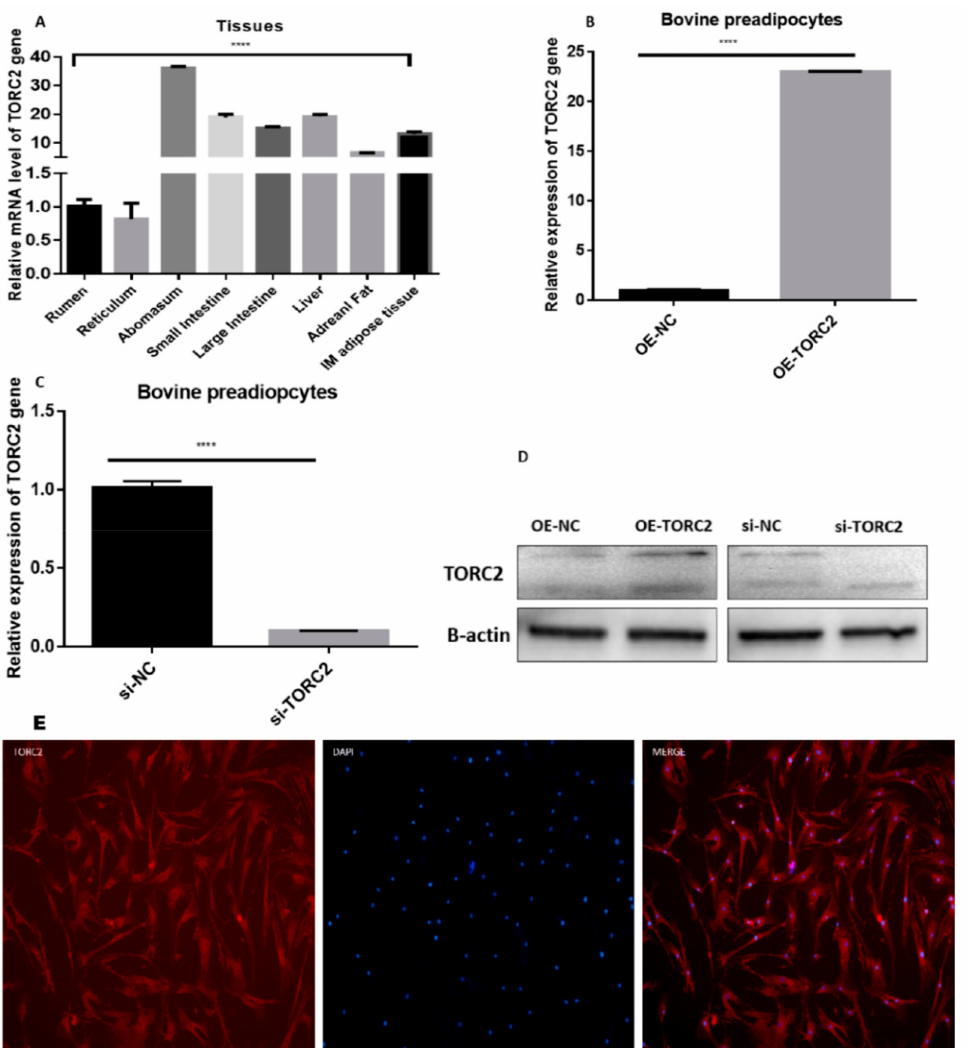
Figure 1. Transfection e ffi ciency, tissue and cellular expression and sub cellular localization of the transducer of regulated cAMP response element-binding protein (CREB) 2 ( TORC2 ) gene. ( A ) The mRNA expression level of the TORC2 gene in di ff erent tissues. Glyceraldehyde 3-phosphate dehydrogenase ( GAPDH ) was used as the housing gene ( B , C ) Real time qPCR was used for the detection of the TORC2 gene in preadipocytes transfected with OE-NC, OE-TORC2, siNC, and siTORC2. ( D ) Western blot analysis of the TORC2 protein gene in adipocytes transfected with OE-NC, OE-TORC2, siNC, and siTORC2. The analysis in ( D ) shows the overexpression e ffi ciency of OE-TORC2 compared with OE-NC, and the silencing e ffi ciency of TORC2 after transfecting the siTORC2 compared with siNC. ( E ) Subcellular localization of TORC2, immunofluorescence with the anti-TORC2 antibody (red), and nuclei were visualized with DAPI (blue) in bovine adipocytes. The right panel shows merged views. Pictures were captured though an Olympus IX71 microscope (OLYMPUS, Tokyo, Japan). One-way ANOVA and t-test were used for statistical analysis. Asterisks indicate significant variations. **** p < 0.0012.2. TORC2 promotes preadipocyte